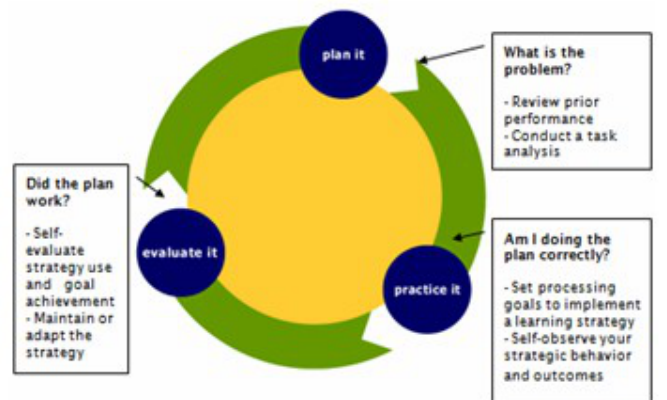
Figure 1. Zimmerman’s Model of Self-Regulated Learning (Zimmerman,